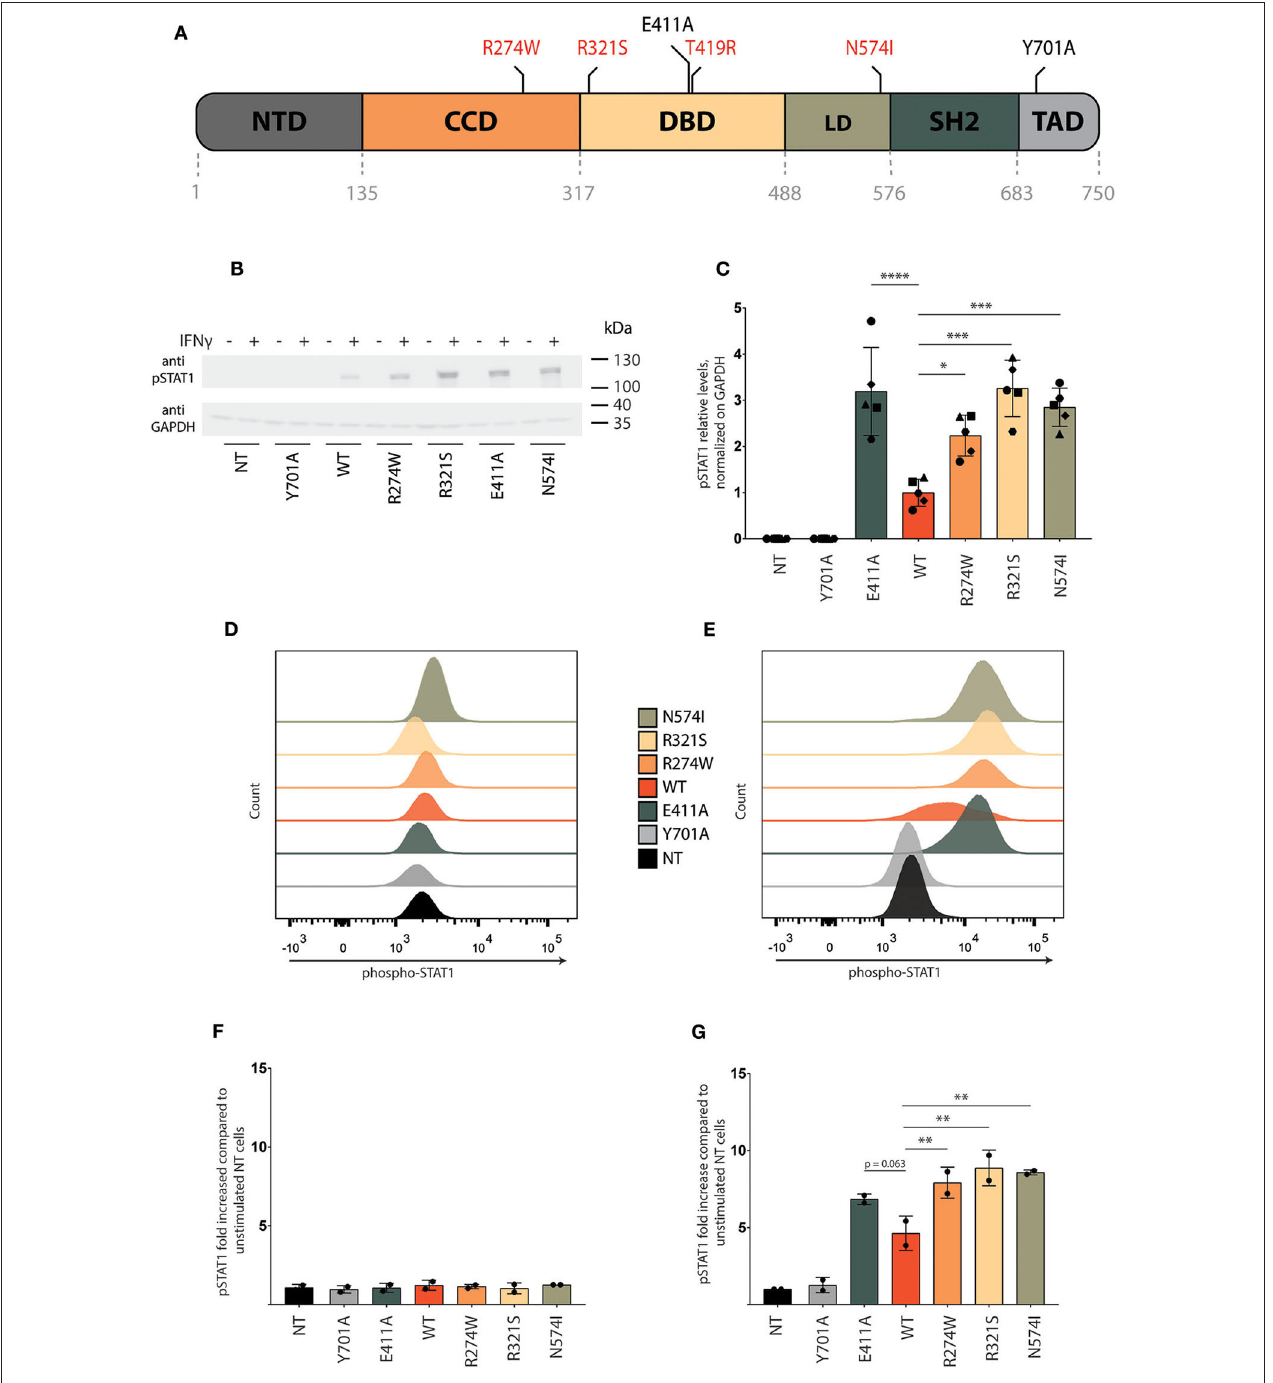
FIGURE 1 | Characterization of STAT1 GOF mutant cell lines. (A) Representative scheme of STAT1 and its domains: N-terminal domain (NTD), coiled-coil domain (CCD), DNA binding domain (DBD), linker domain (LD), SRC homology domain (SH2), and transactivation domain (TAD). Positions of the GOF mutations (R274W, R321S, T419R, N574I) analyzed in this study are indicated in red, as well as the position of the controls in black (E411A, Y701A). (B) Representative Western blot of U3A cell lysate stained with anti-pSTAT1 and anti-GAPDH. Cells were stimulated for 1h with IFN γ (1 U/ µ l) or left unstimulated. Five independent experiments were pooled together. (C) Quantification of Western blot pSTAT1 levels of U3A cells stimulated for 1h with IFN γ (1 U/ µ l) from five independent experiments. (D,E) Representative pSTAT1 levels in the respective stable U3A cells stimulated for 1h with IFN γ (E) or left unstimulated (D) measured via flow cytometry. (F,G) Quantification of pSTAT1 levels measured via flow cytometry of U3A cells stimulated for 1h with IFN γ (1U/ µ l) (G) or left unstimulated (F) , for two independent experiments. Data are represented in bar graphs as mean ± standard deviation. Statistical analysis: One-way ANOVA with Dunnett’s post-hoc test. * P < 0.05 ; ** P < 0.01 ; *** P < 0.001 ; **** P < 0.0001.